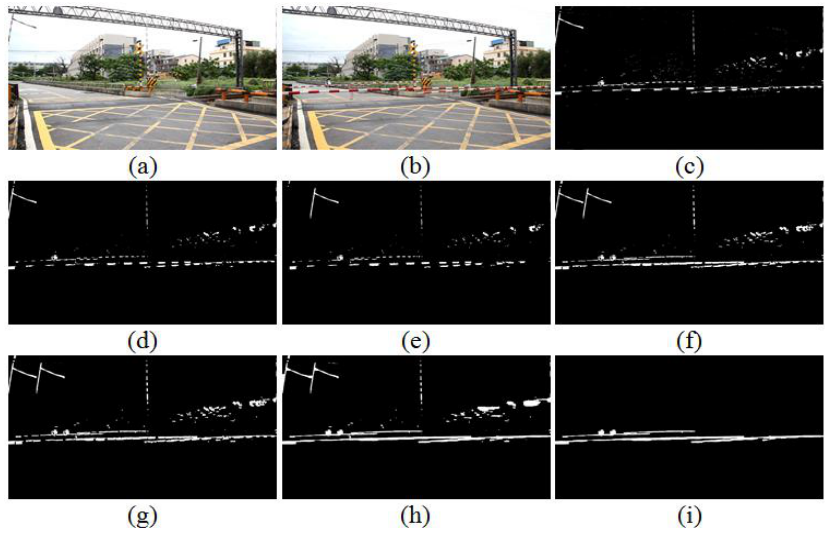
Figure 12. The gates extraction case-1, the railway crossing of the Doudile Road: ( a ) the background image; ( b ) the input test image; ( c ) the image after extracting white part; ( d ) the image after filtering the noise; ( e ) white part rotation right of (d); ( f ) the image after merging (d) and (e); ( g ) the image after dilation operation, ( h ) the image after the closing operation, ( i ) the image after lengthy fitting operations.